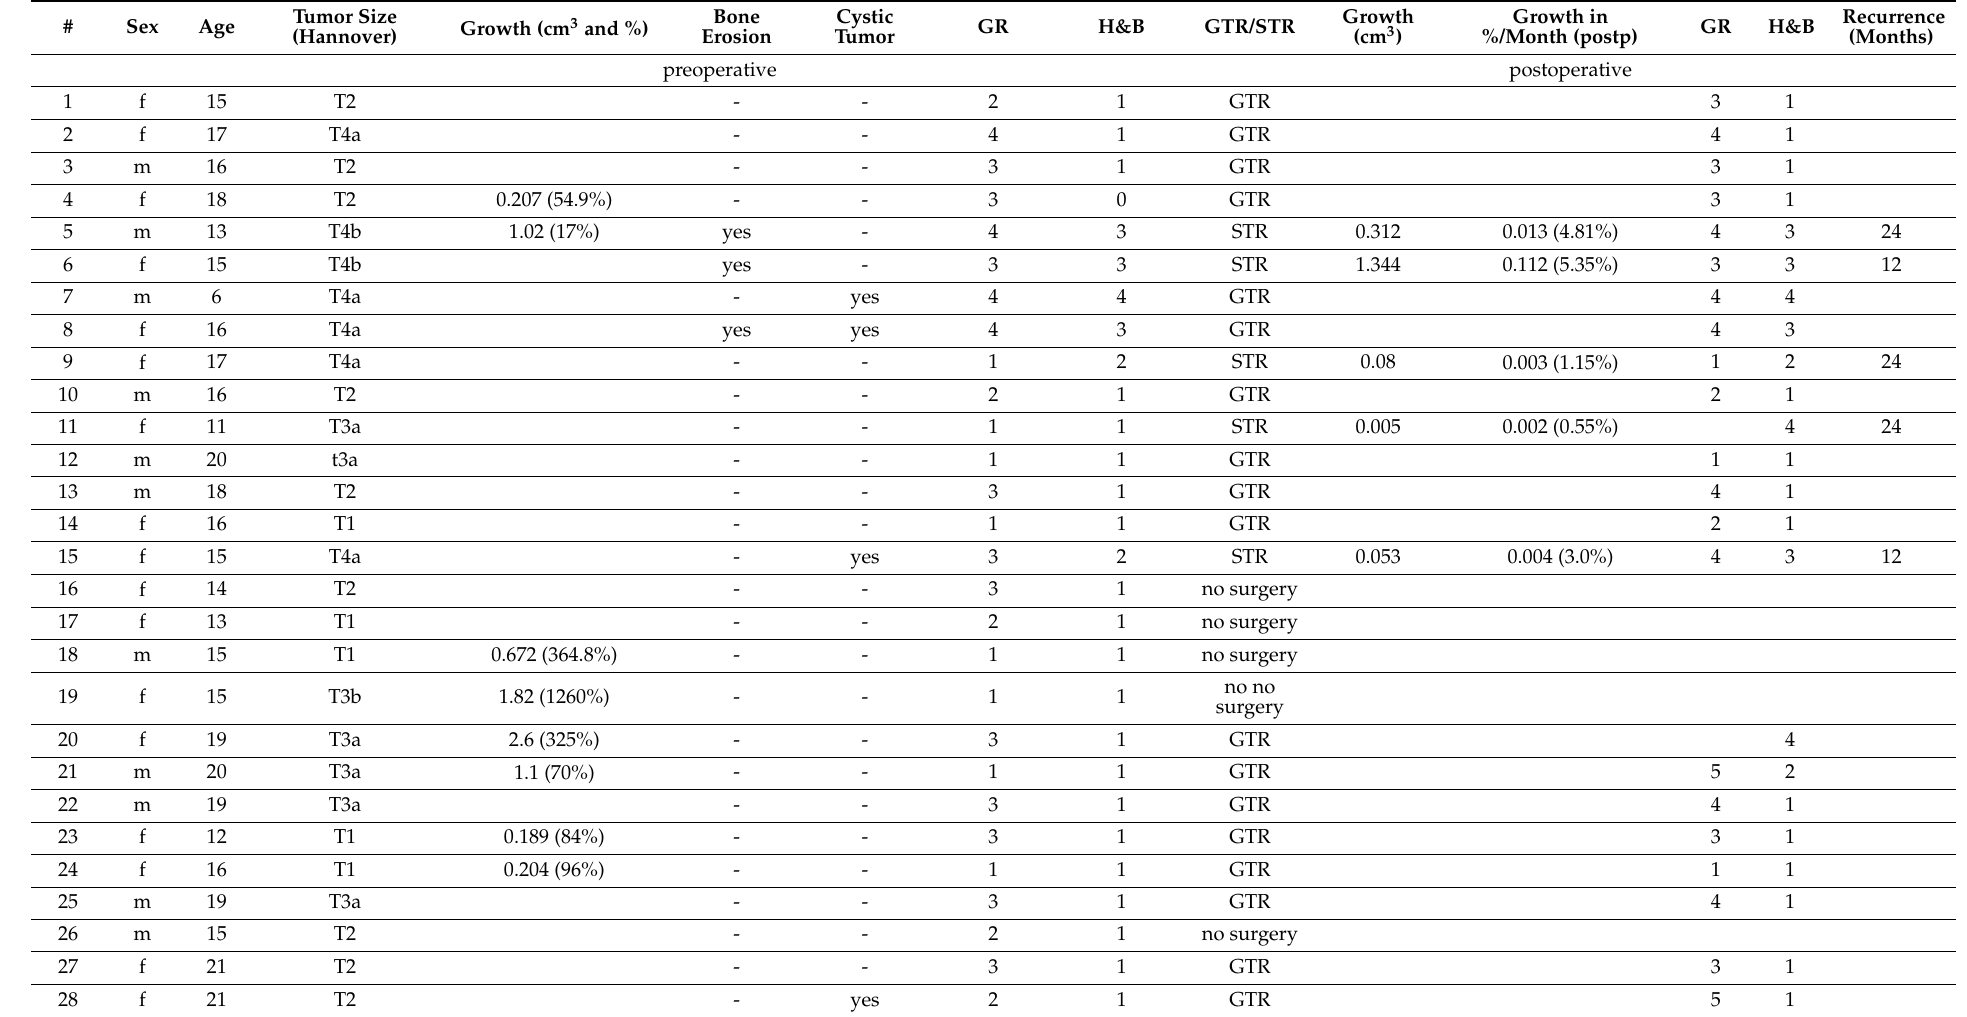
Table 1. Basic patient